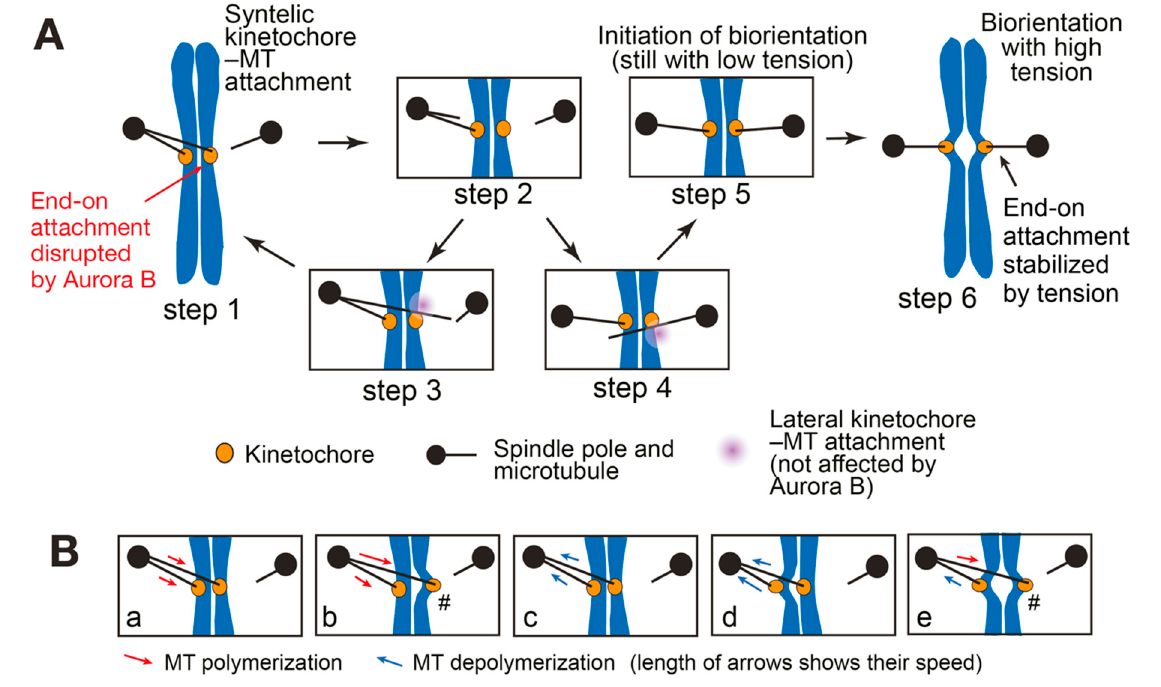
Figure 2. ( A ) Diagram shows a model of the error correction process, in which an aberrant kinetochore–MT interaction (syntelic attachment) is resolved to establish biorientation [33]. Each step is explained in the text. This figure was taken from Doodhi et al. [49] after modification; ( B ) the dynamics of kinetochore ‐ attached MTs and predicted effects on sister kinetochores in a syntelic attachment; in ( a , c ) the motion of two sister kinetochores is coordinated; in ( b , d , e ), different dynamics of kinetochore ‐ attached MTs generate twisting forces on sister kinetochores. The kinetochore–MT interaction may be disrupted especially at kinetochores marked with # (see text). Note that the twisted kinetochores in ( b , d , e ) do not represent an application of full tension (in contract to Step 6 in ( A )) since an end ‐ on attachment would be disrupted at one of the sister kinetochores before full tension is applied.